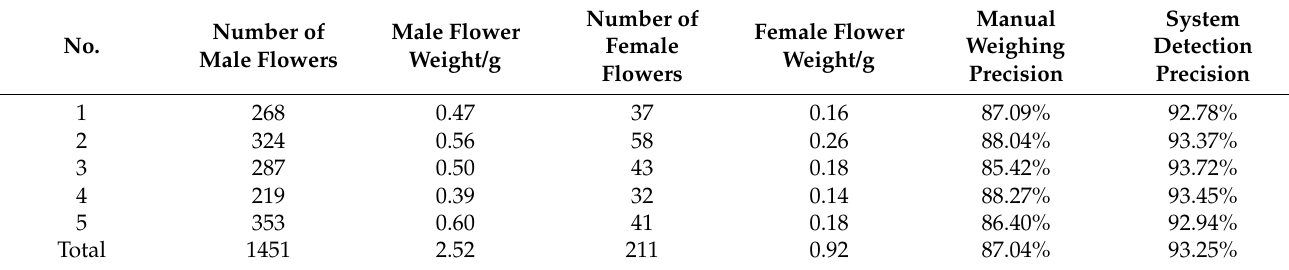
Table 8. System testing vs. manual weighing